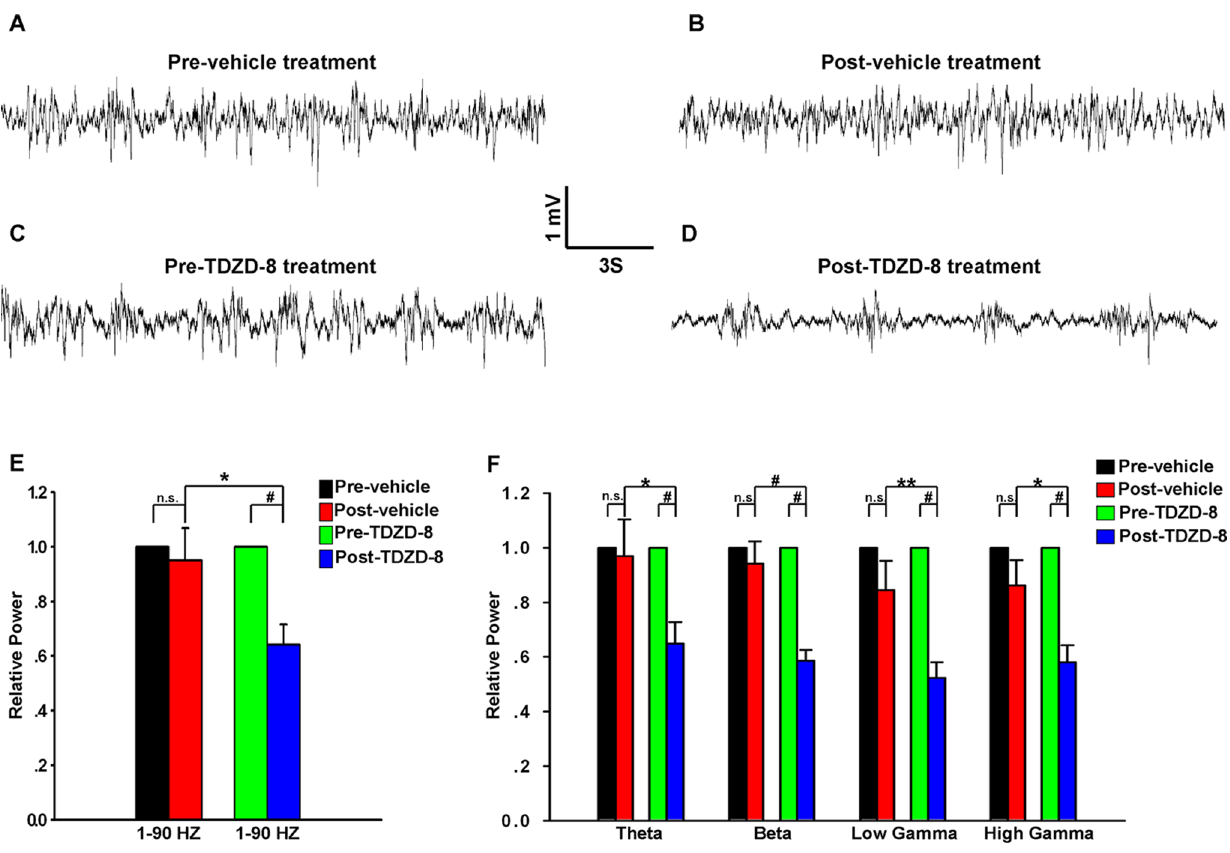
Figure 4. Electrophysiological recordings of the spontaneous oscillatory activity in the granular cell layer of the OB. A–D: Raw data displaying representative examples of spontaneous LFP recordings. A & B show the raw spontaneous LFP signals in pre- and post-vehicle treated OB from the same mouse, respectively. C & D presents the raw LFP signal from a pre- and post-TDZD-8-treated mouse, respectively. E shows the changes in relative power (1–90 Hz) in the vehicle- and TDZD-8- treated groups. There is significant difference between the OBs of mice before and after TDZD-8 treatment (P , 0.001), but no significant difference between the pre- and post-vehicle-treated mice (P=0.685); significant difference between post-vehicle and TDZD-8 treatment (P=0.028). F: The relative power of the four frequency bands did not show significant differences between pre- and post-vehicle treatment (all, P . 0.05). The pre- and post-TDZD-8-treated mice had significant differences in the four frequency bands (all, P , 0.001); significant difference between post vehicle and TDZD-8 treatment (Theta, P=0.037; Beta, P , 0.001; low Gamma, P=0.008; high Gamma, P=0.014). The data obtained from the GCL in the vehicle-treated (10 mice) and TDZD-8 (16 mice). Not significant (n.s.). * P , 0.05; ** P , 0.01; # P , 0.001. The group data shown are the average 6